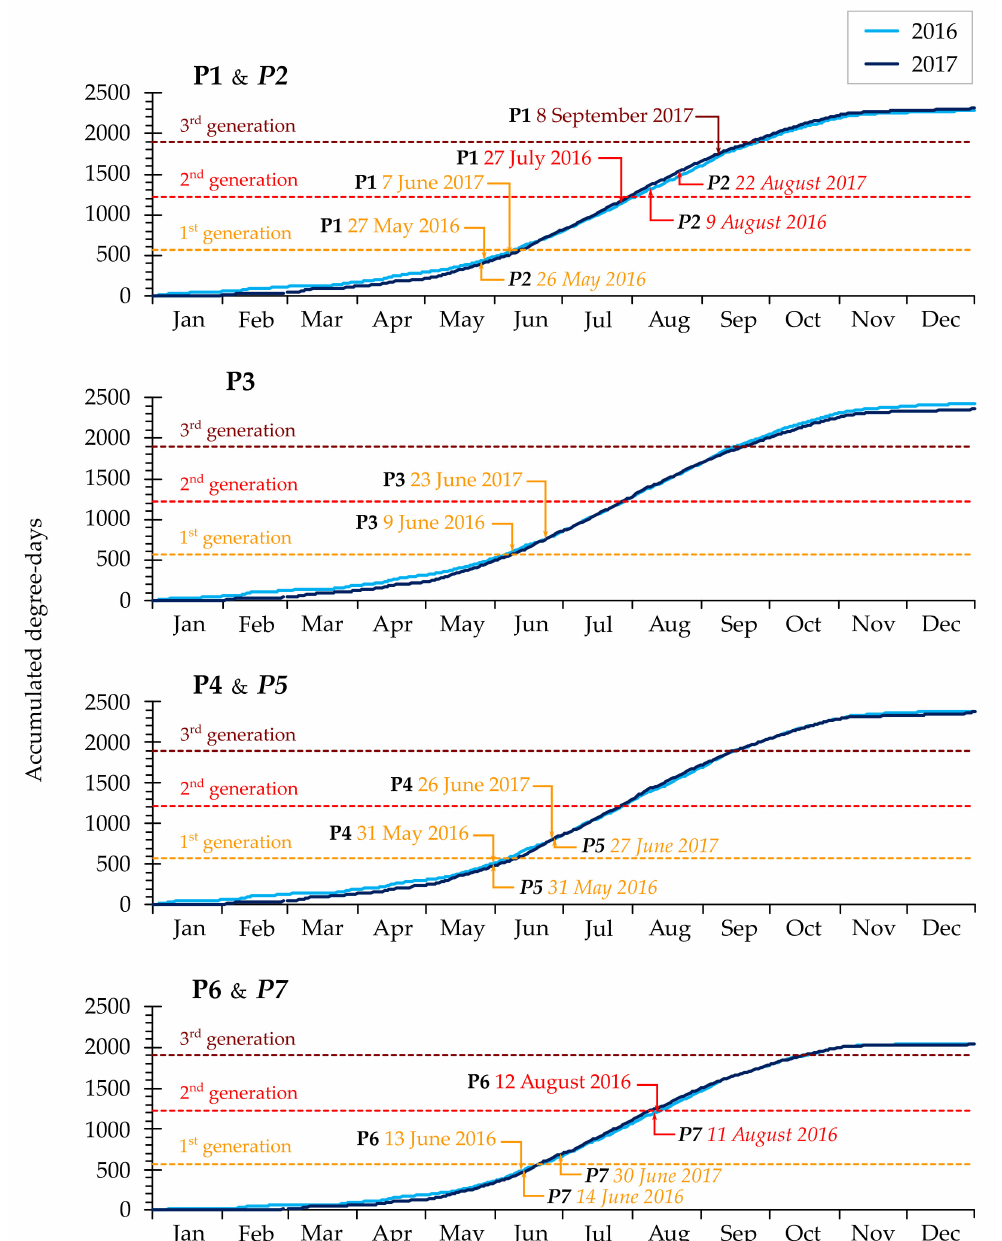
Figure A1. Accumulated degree-days (ADD) in the seven plots (P1–P7) during 2016 and 2017. The application dates are indicated for each plot and each year. The treatment threshold for the first generation is indicated in orange (at 570 ADD), in red for the second generation (1220 ADD) and in maroon for the third (1900 ADD). Lower development threshold temperature for Aonidiella aurantii = 11.7 ◦ C. The temperature data were obtained from the weather stations of the Spanish SIAR (“Servicio de Informaci ó n Agroclim á tica para el Regad í o”, Agroclimatic Information Service for Irrigation) network